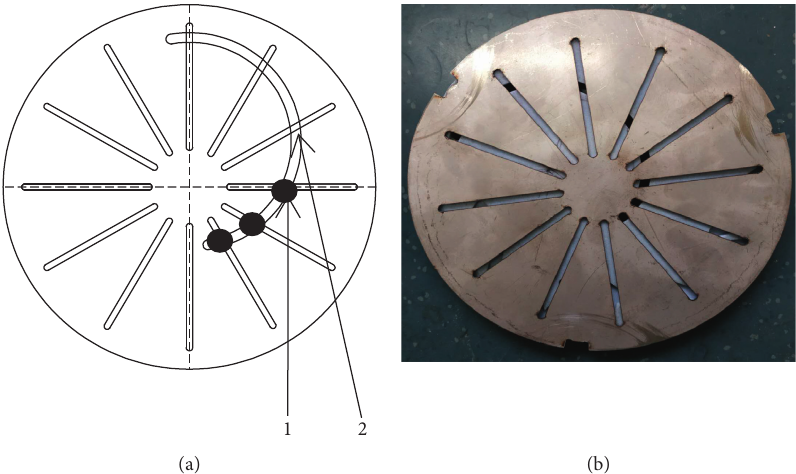
Figure 4: Combination of guide groove plate and air suction plate. (a) Design diagram. (b) Physical diagram. (1) Cotton seed. (2) Hole of combined air